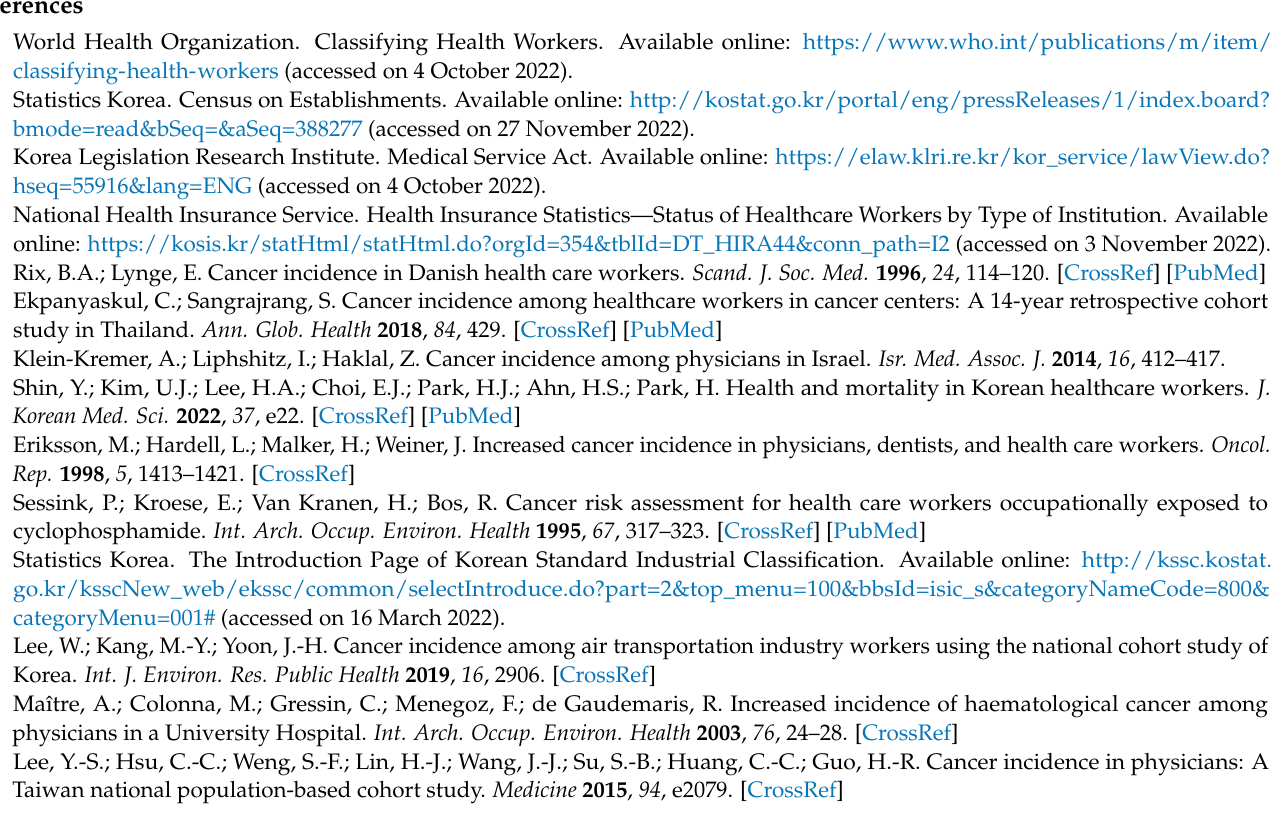
Table S3: Observed Number of Deaths, Standardized Incidence Ratio and 95% Confidence